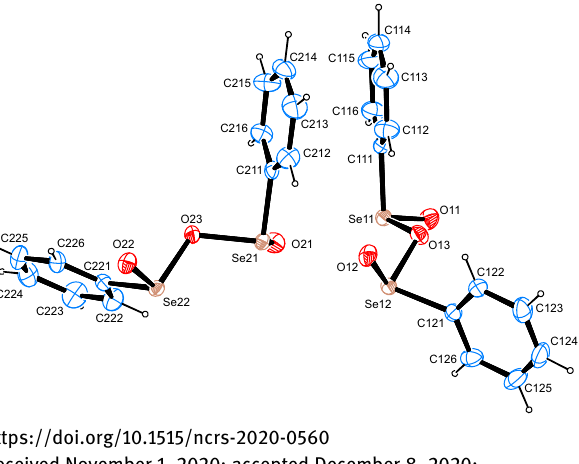
Table  : Data collection and